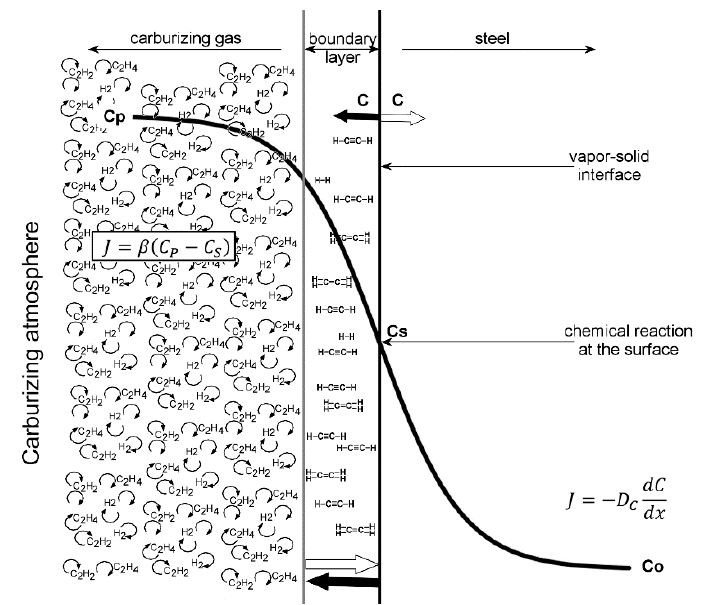
Figure 1. Mechanisms of carbon transfer during carburizing and their primary control parameters: the mass transfer coefficient ( β ) defining carbon atom flux ( J ) from the atmosphere to the steel surface and the diffusion coefficient of carbon in steel ( D ) at austenitizing temperatures [14].